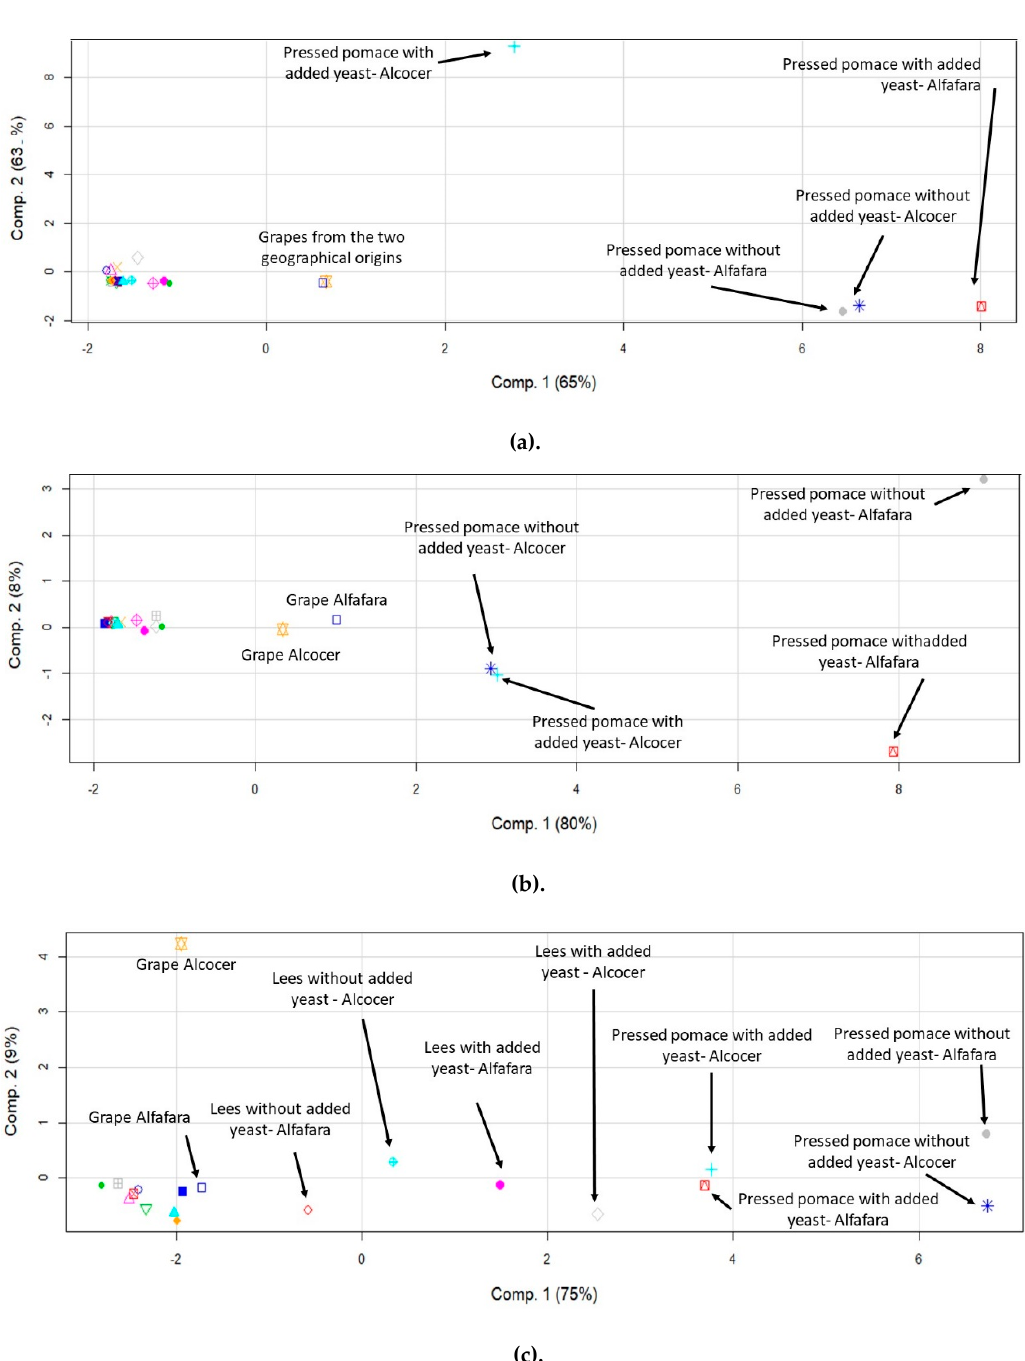
Figure 2. Score plots of the principal component analysis corresponding to the data expressed as concentration of elements for fractions of the winemaking process originated from two different geographical locations with and without yeast addition. ( a ) Major elements; ( b ) trace elements; ( c ) rare earth elements.